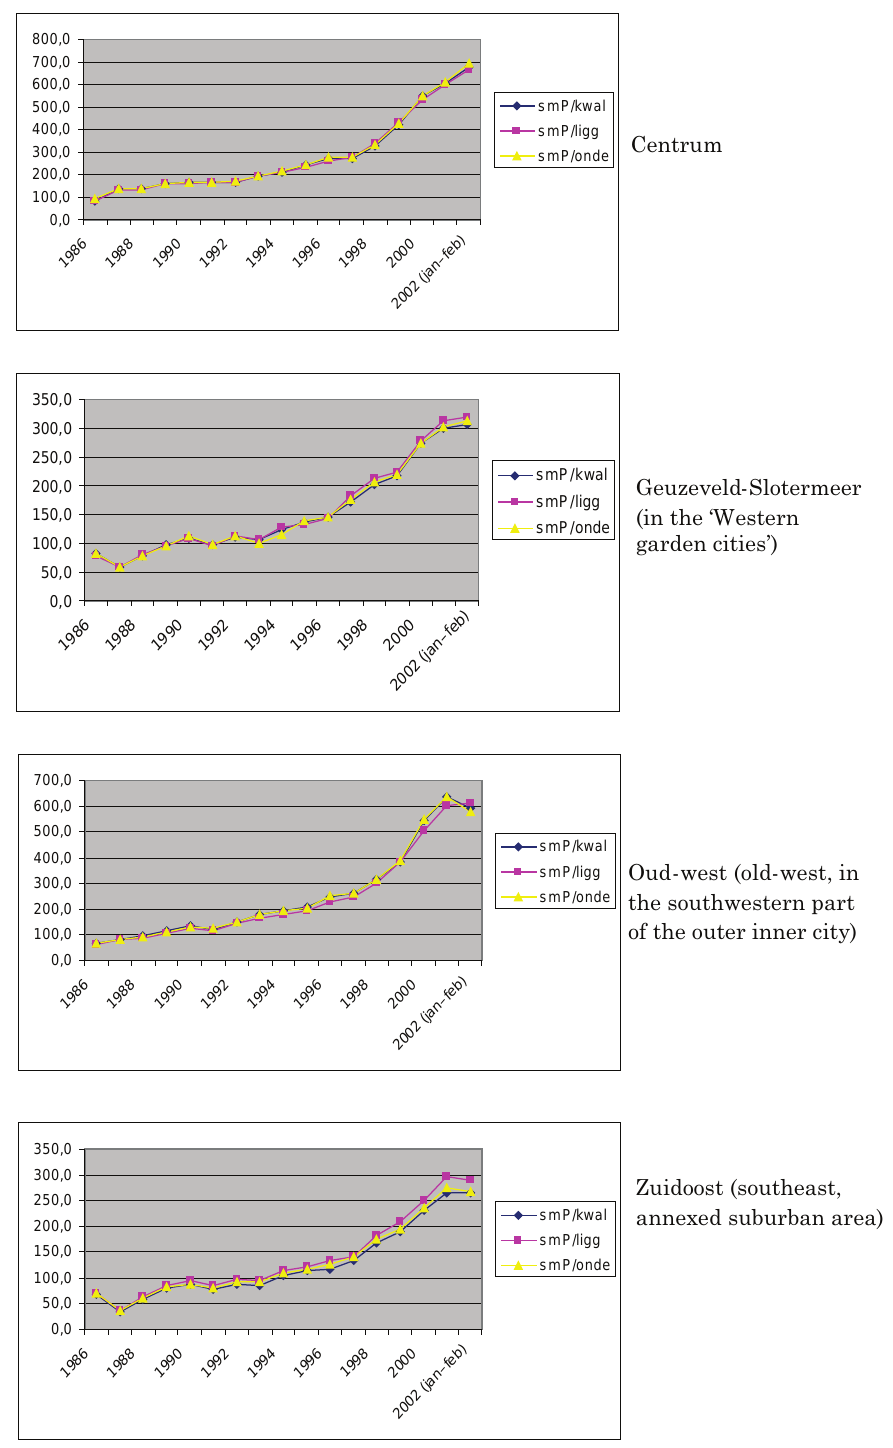
Figure 2. time-series of the square meter price related to three different quality measures in four districts of